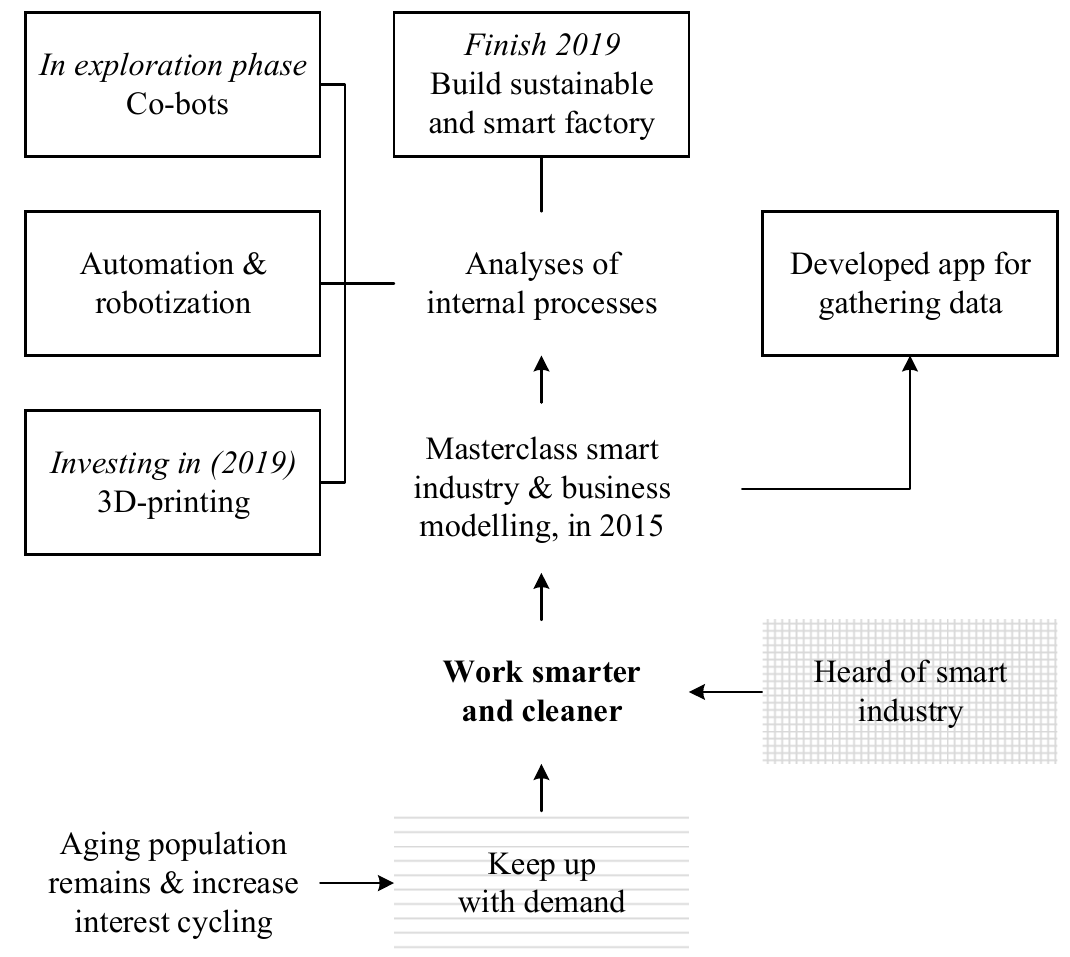
Adm. Sci. 2020 , 10 , 30 Figure A7. Flow chart for Kornelis Caps and Closures. Figure A7. Flow chart for Kornelis Caps and Closures.